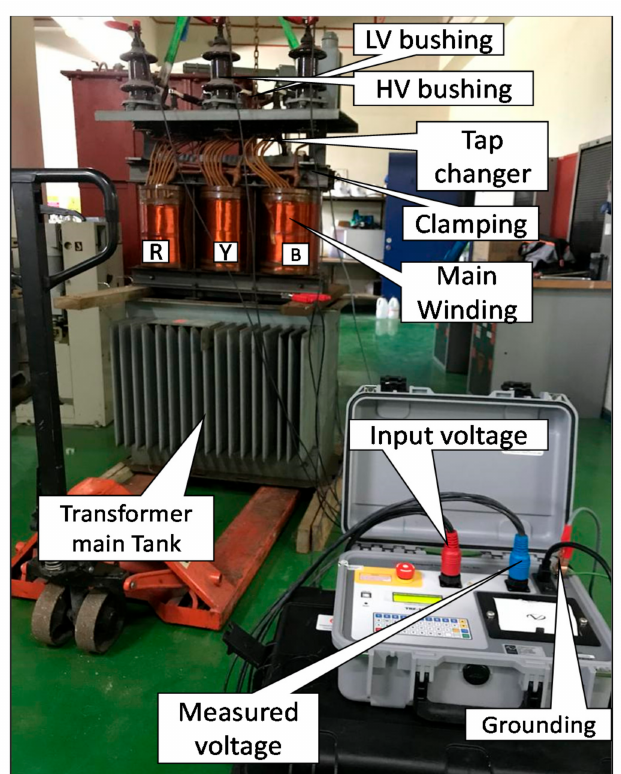
Figure 10. The 500 kVA distribution transformer used in the case study.